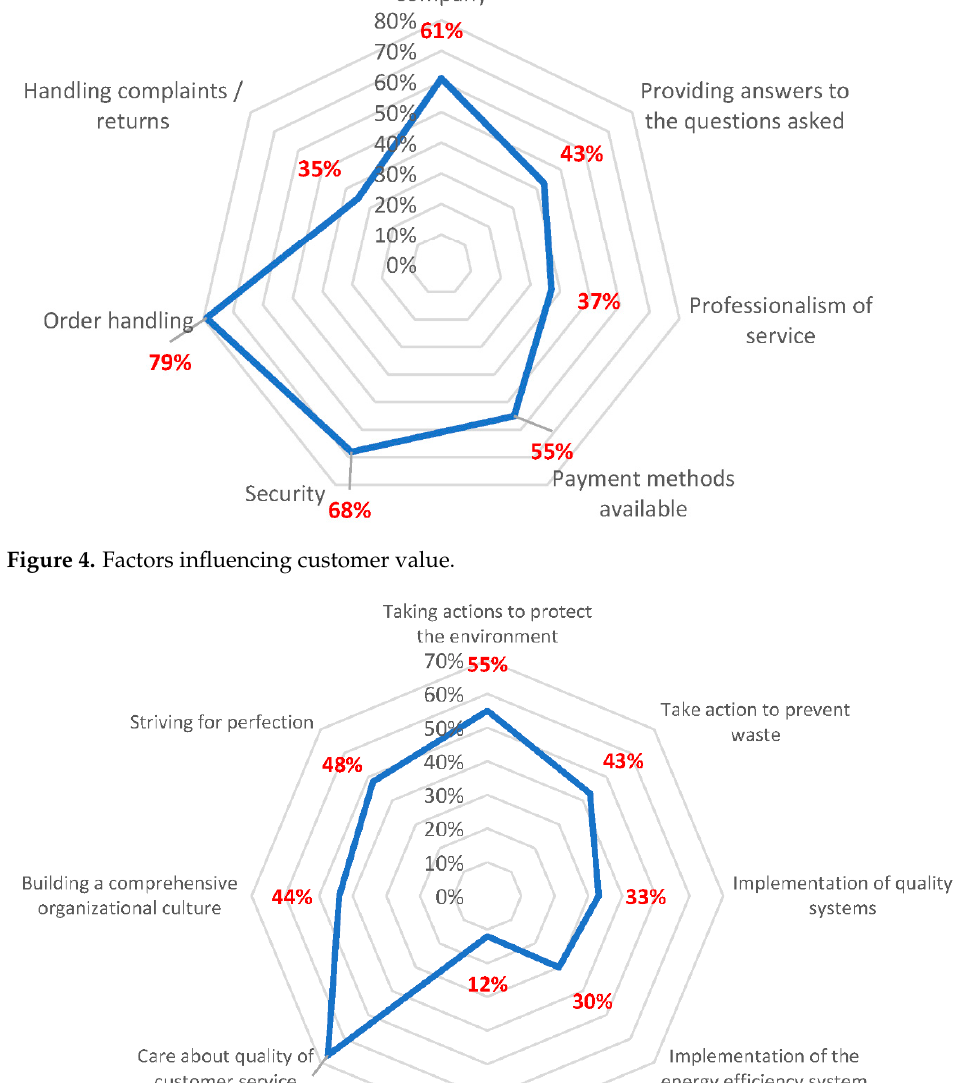
Figure 4. Factors influencing customer value .